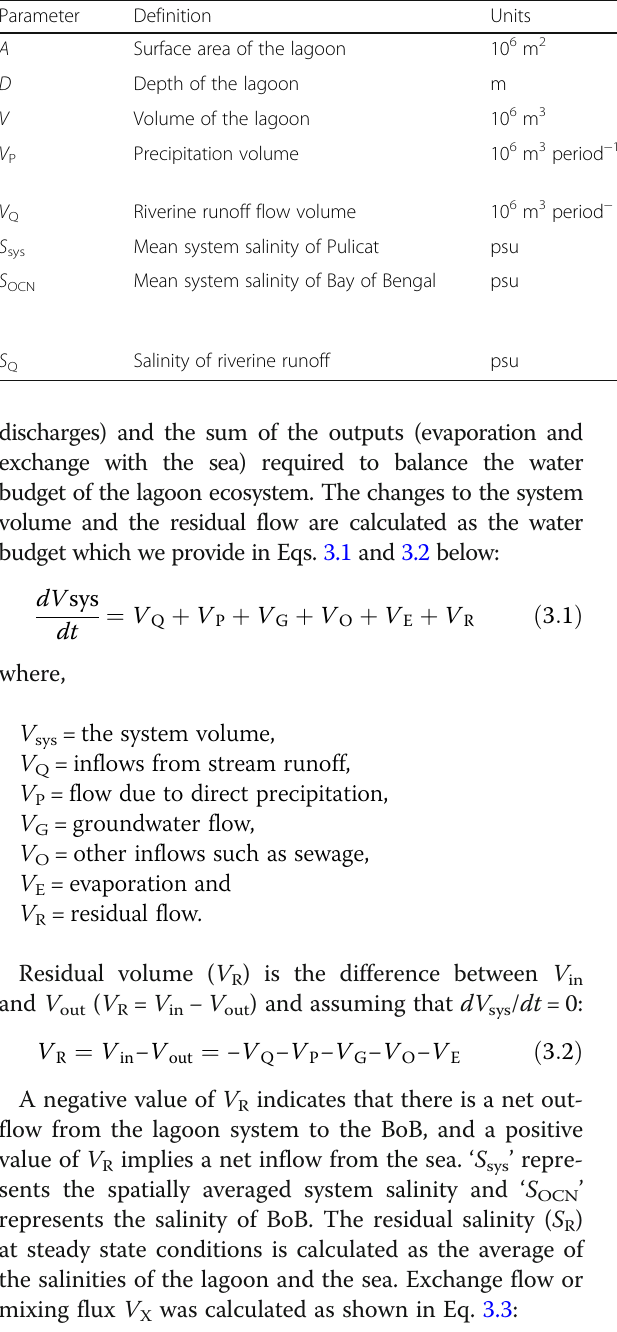
Table 1 The variables used in the construction of LOICZ budget as per the modelling guidelines detailed in Gordon Jr. et al.